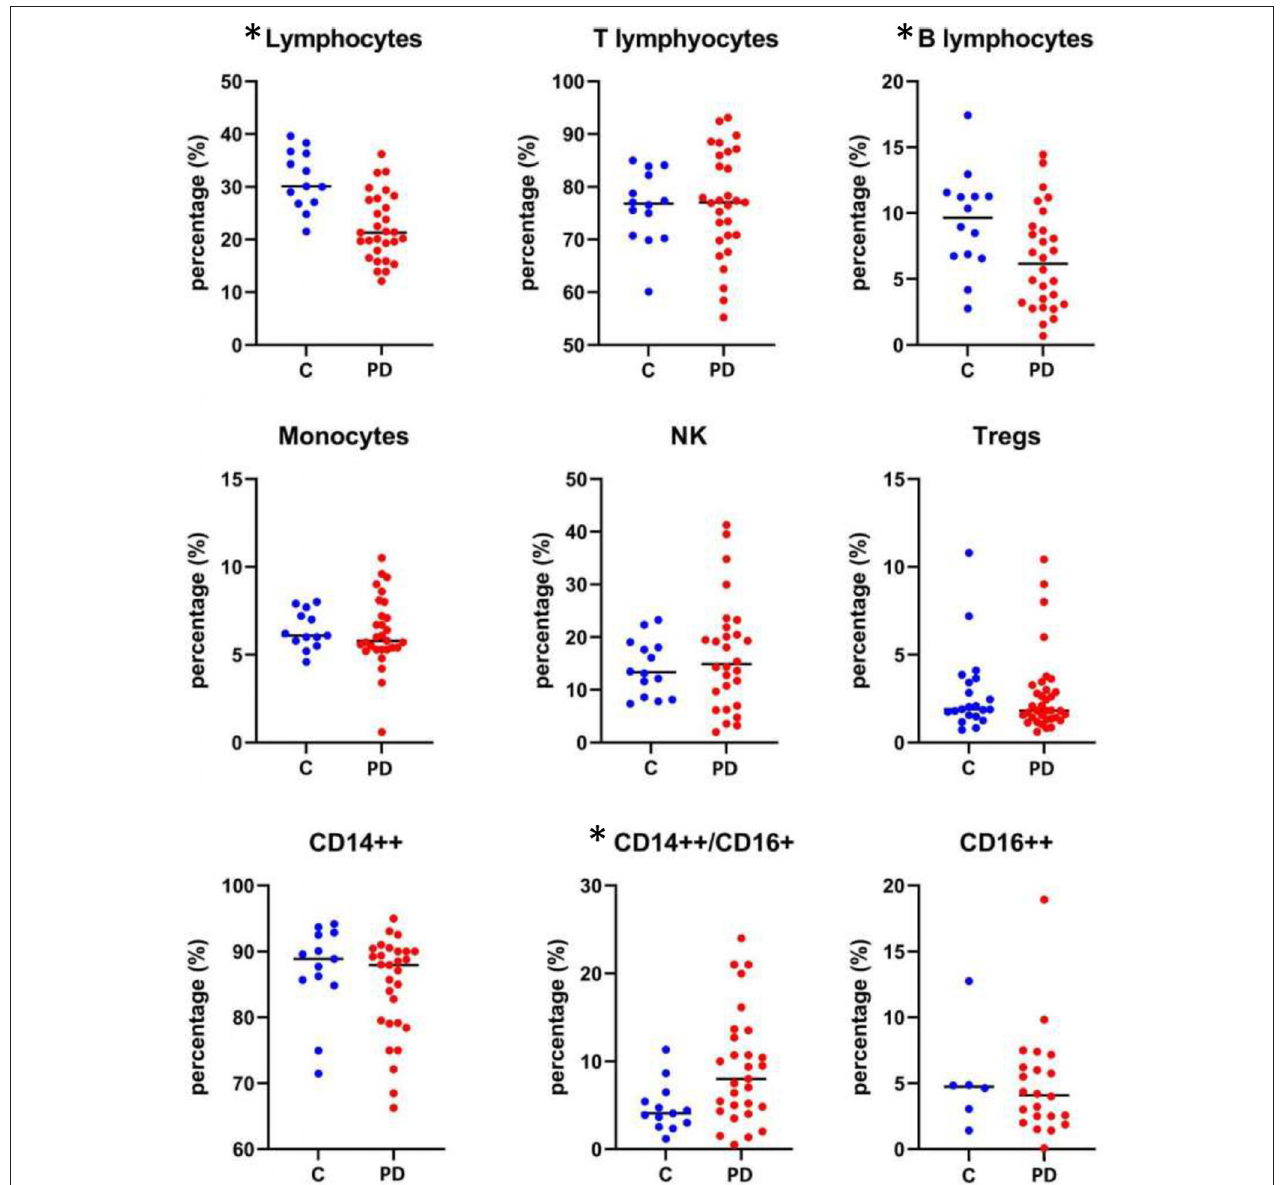
FIGURE 3 | Immune cells subpopulations counts in control and PD patients. * p < 0.05, Values are expressed as mean or medians.